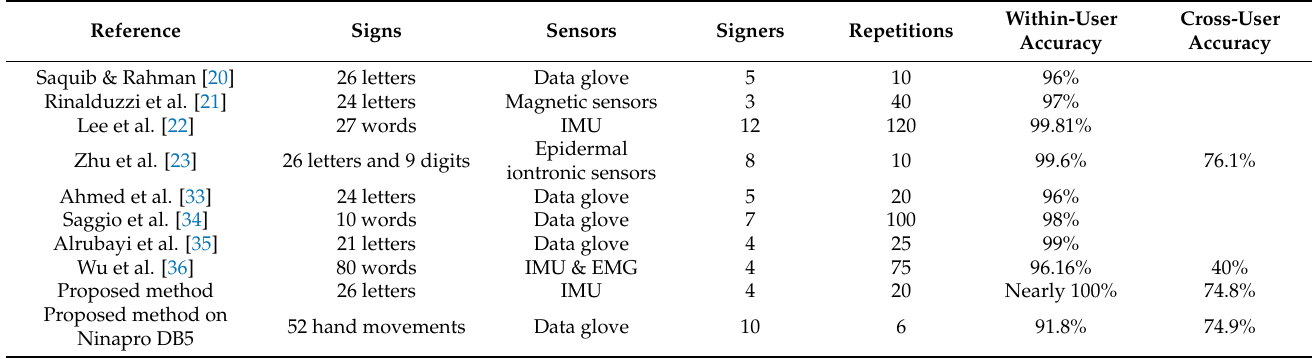
Table 7. Comparison of sign language recognition with previous